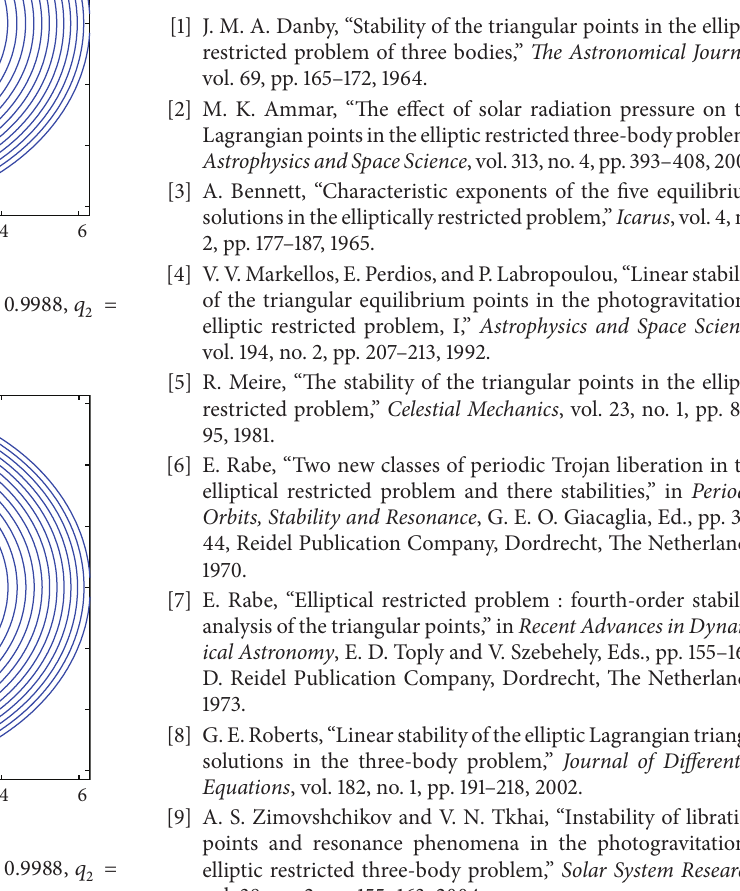
of zero velocity around triangular equilibrium point. It is observed that the region within the curves, the infinitesimal will remain